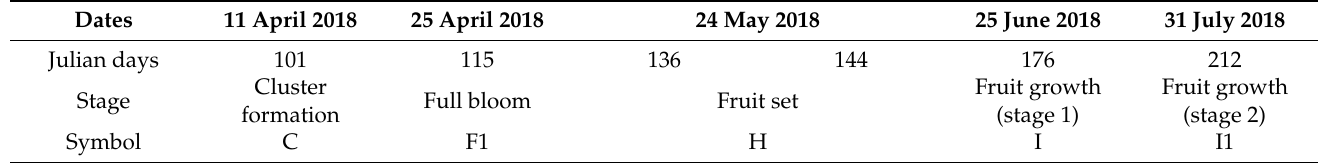
Table 2. Observed phenological stages during the growing season March–November